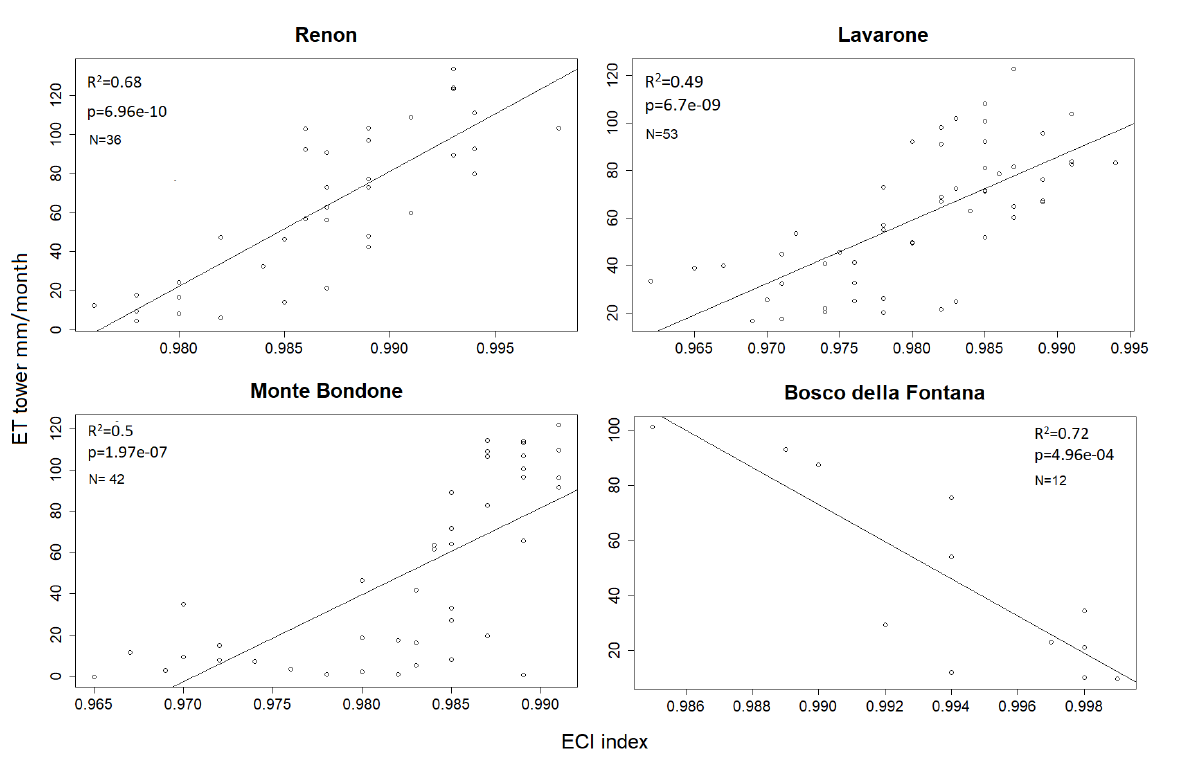
Figure 4. Linear regression between the ET (ET tower) and the monthly ECI when the snow cover is lower than 50%. N is the number of data points.